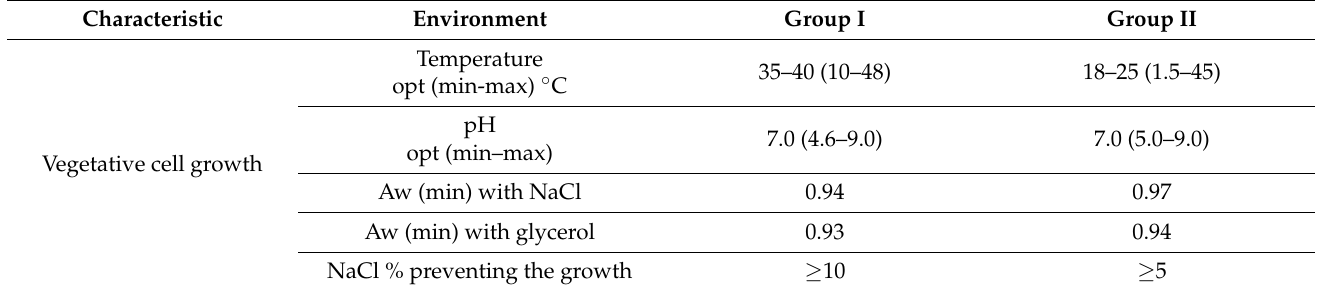
Table 3. Growth, survival, and toxin production characteristics of C. botulinum strains implicated in food safety